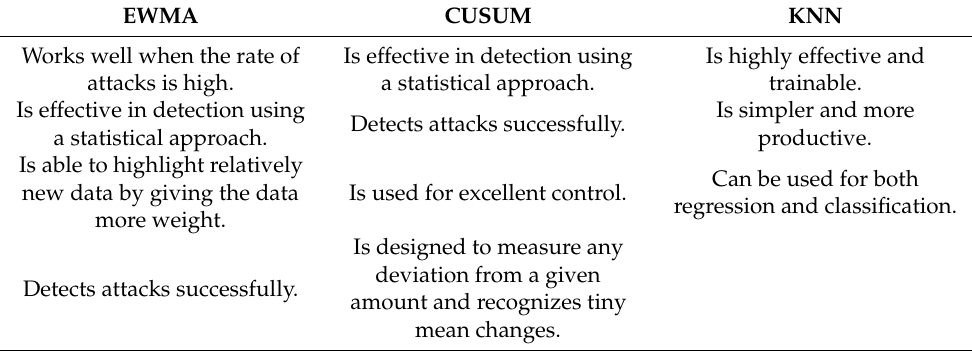
Table 1. Comparison of EWMA, CUSUM, and KNN. EWMA CUSUM KNN Works well when the rate of Is effective in detection using Is highly effective and attacks is high. a statistical approach. trainable. Is effective in detection using Is simpler and more Detects attacks successfully. a statistical approach. productive. Is able to highlight relatively Can be used for both new data by giving the data Is used for excellent control. regression and classification. more weight. Is designed to measure any deviation from a given Detects attacks successfully. amount and recognizes tiny mean